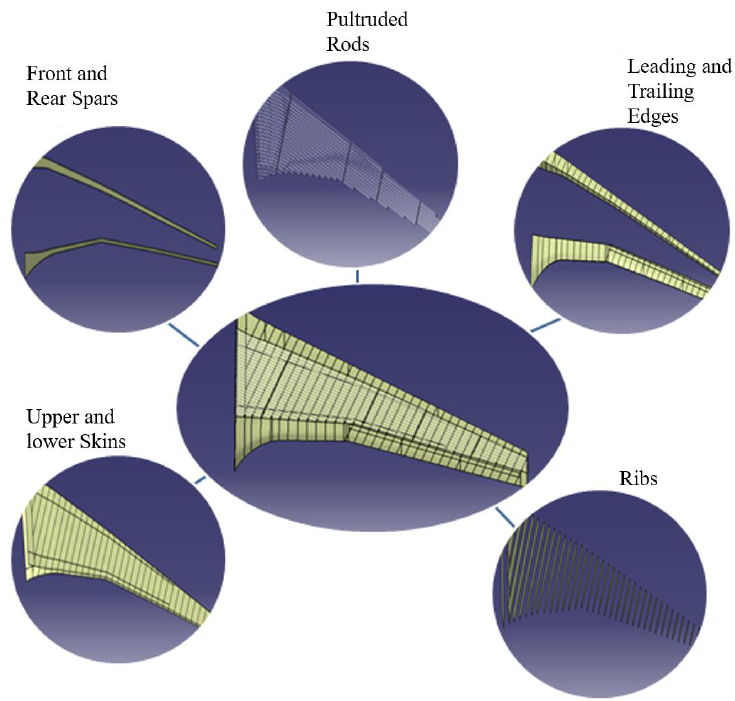
Figure 2. Components of BWB wing assembly.